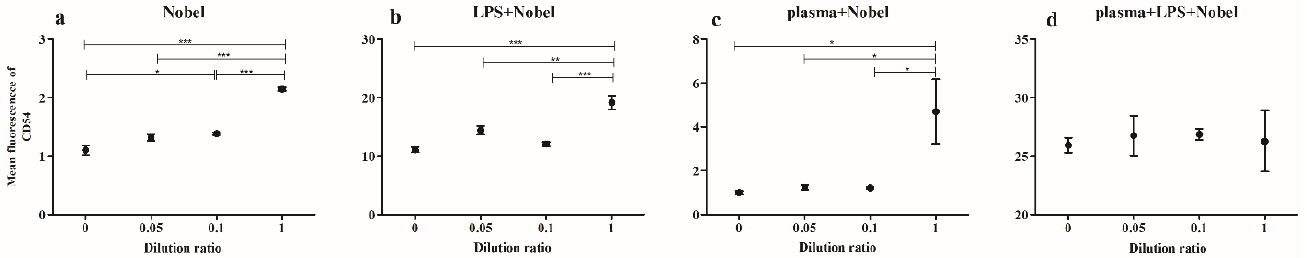
Figure 6. Changes in the expression level of CD54 by THR-1 cells after 24 h of incubation with NSMP from the Alpha-Bio system: ( a ) incubation with NSMP; ( b ) incubation with NSMP and LPS; ( c ) incubation with NSMP and blood plasma from healthy donors; ( d ) incubation with NSMP, LPS and blood plasma from healthy donors. Statistical significance levels: * p < 0.05, ** p < 0.01, *** p < 0.001.